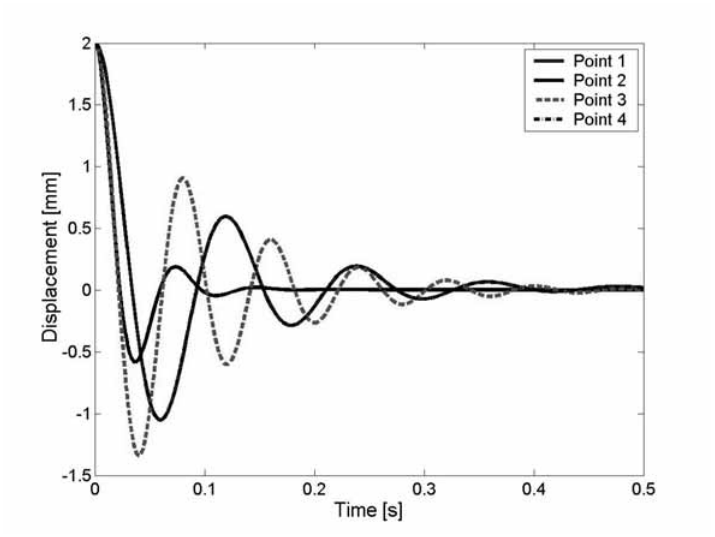
Fig. 31. Optimized engine mass displacement transient response.